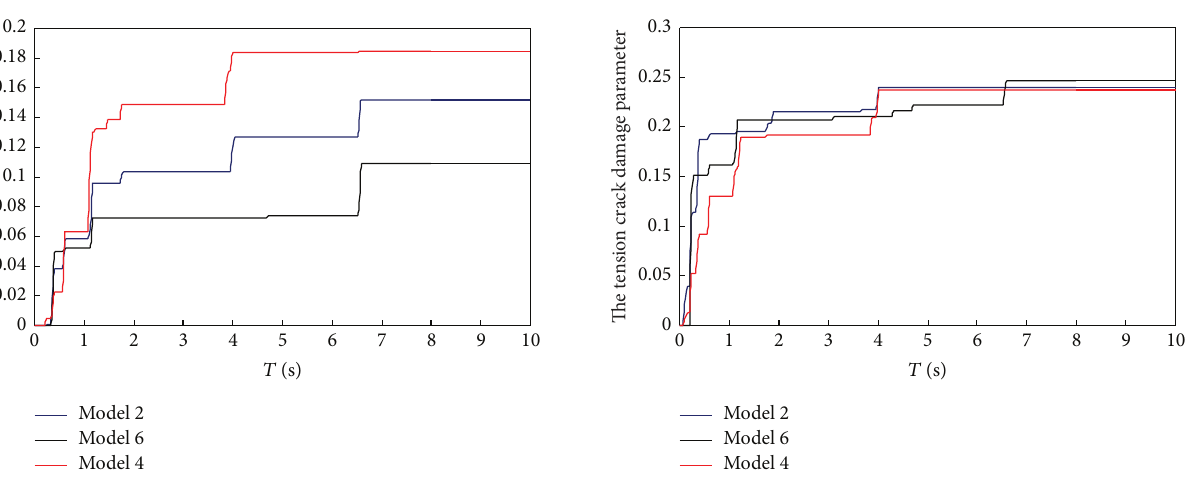
Figure 24: The tension crack damage parameter of spandrel under Lixian County ground motion.